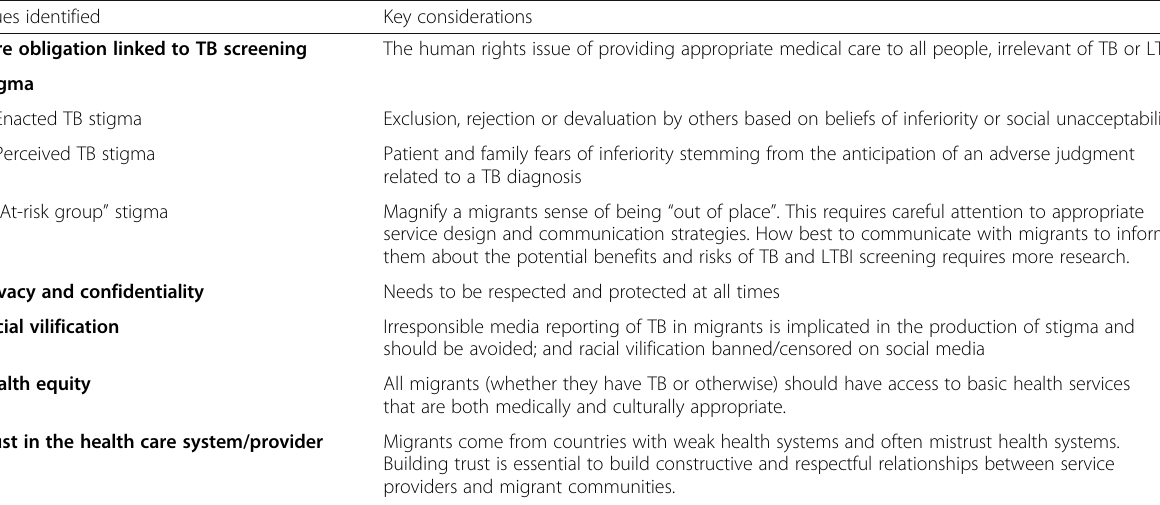
Table 1 Overview of ethical issues related to migrant TB